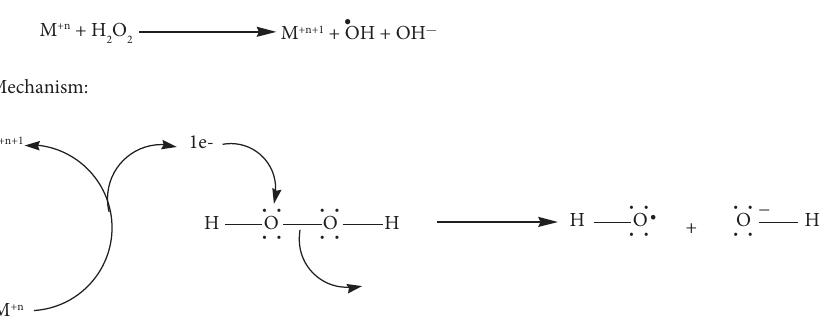
Figure 8: Mechanism of catalytic chemistry of Fenton nanocatalysts for versatile radical nanotherapeutics.